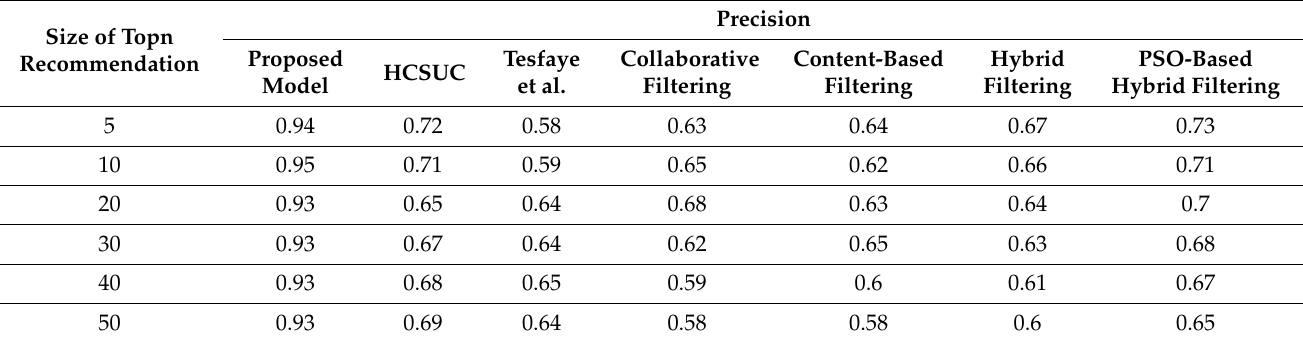
Table 5. Precision according to the Topn Recommendation (Considering Dataset 1 [43]).